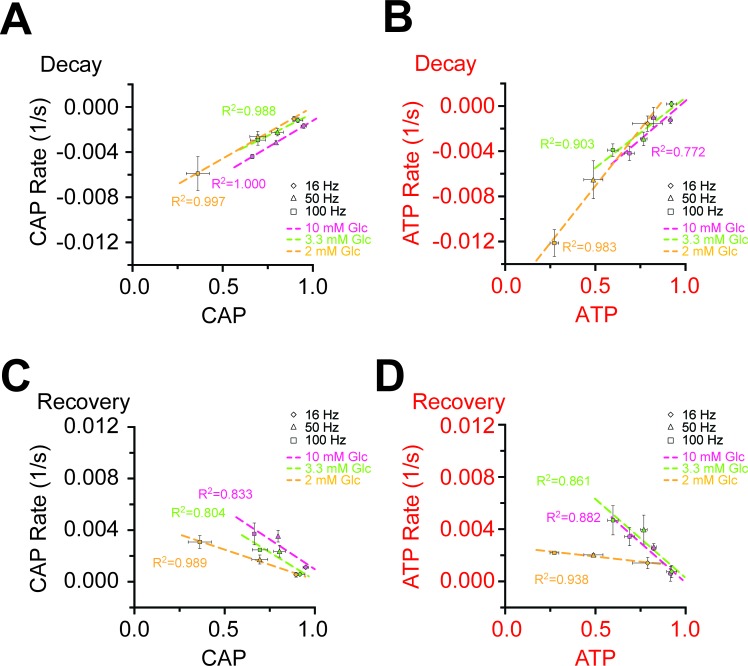
Correlation of the rates and amplitudes of CAP and ATP changes during HFS in different glucose concentrations.(A) Correlation of the velocity of the initial decay of CAP at the beginning of HFS and the amplitude of CAP decay at the end of HFS. The faster the CAP drops, the larger the CAP amplitude is. (B) Same analysis for ATP as for CAP area in panel A. Also a faster ATP consumption at the beginning of HFS coincides with a larger decrease in ATP signal amplitude. (C) Correlation of the rates of CAP area recovery after the cessation of stimulation and the amplitudes of CAP changes at the end of the stimulation at different glucose concentrations. The velocity of CAP recovery increases with larger amplitude of CAP decay during stimulation. (D) Same analysis as in C for ATP. ATP recovery rates are strongly depending on the amplitude of ATP decrease during HFS at 10 mM and 3.3 mM glucose, but much less in the presence of 2 mM glucose. The graphs summarize data from n = 5, 5, or 4 nerves for 10 mM, 3.3 mM and 2 mM glucose, respectively.